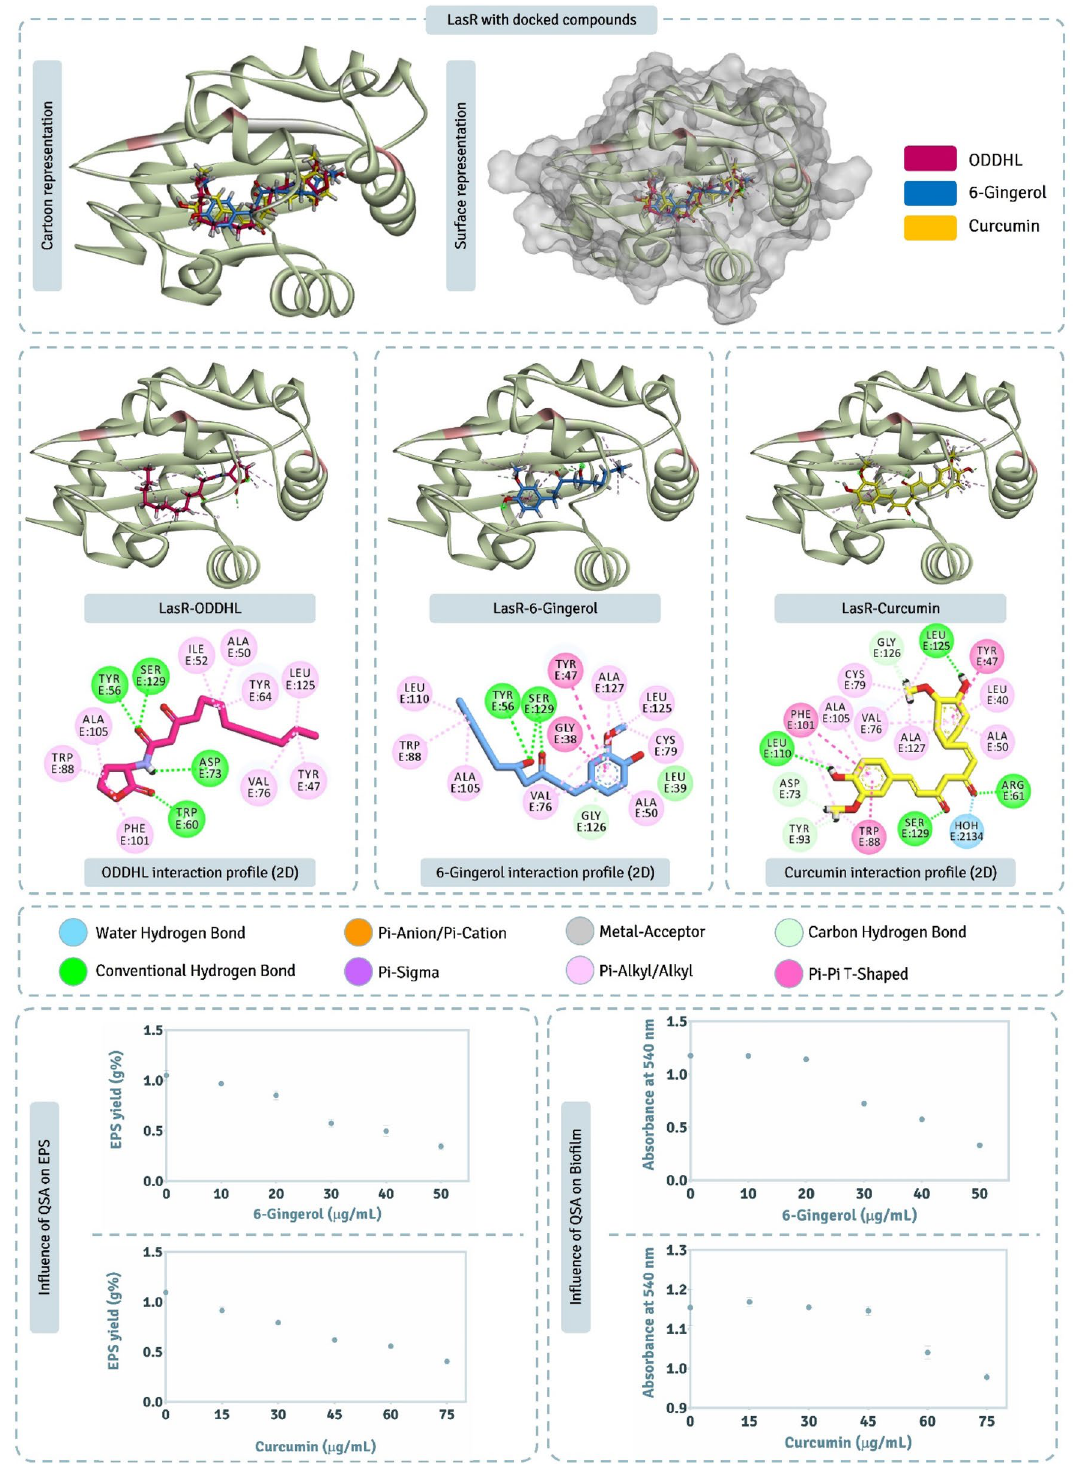
Figure 5. Interaction profile of LasR with 6-Gingerol and Curcumin as predicted by XP docking and assessment of its QSA potential on EPS and Biofilm